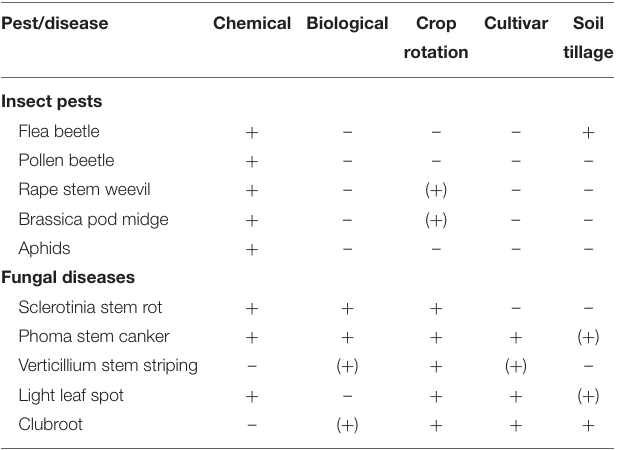
TABLE 3 | Current management options for the control of important pests and diseases in oilseed rape.